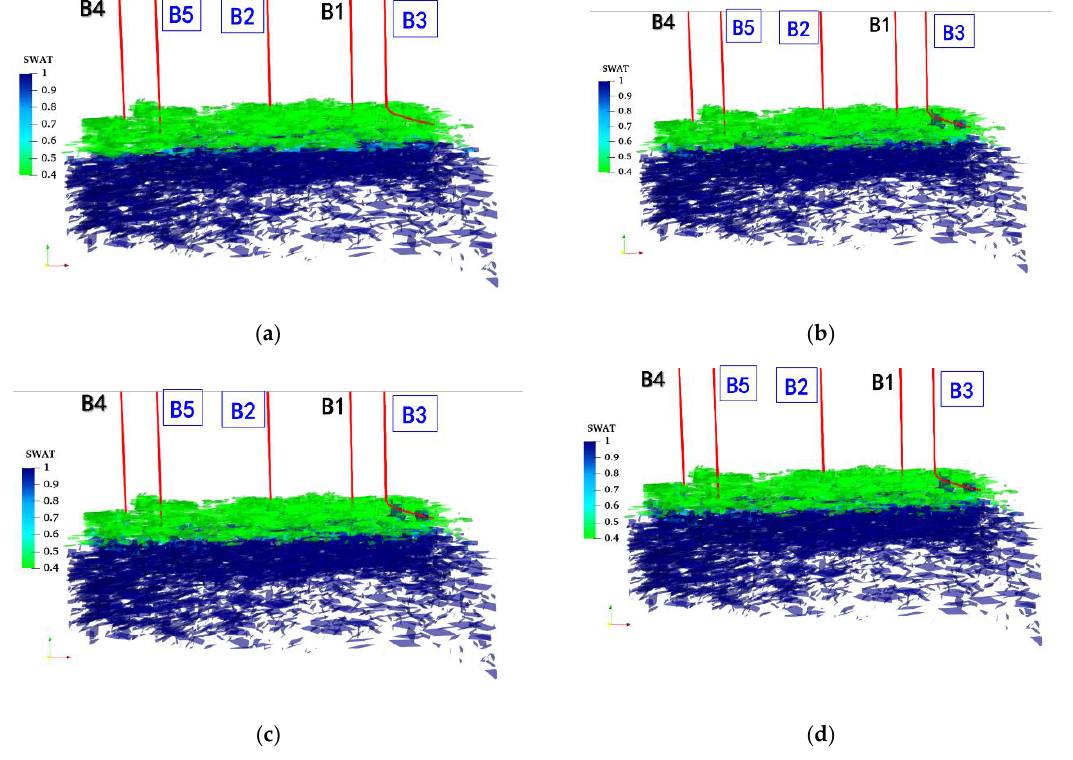
Figure 39. Detailed visualizations of the XZ plane of water saturation on the fractures with five wells and more than 10,000 EDFM-fractures. The water contact transition can be observed: ( a ) after 270 days; ( b ) after 1000 days; ( c ) after 1700 days; ( d ) after 2000 days.